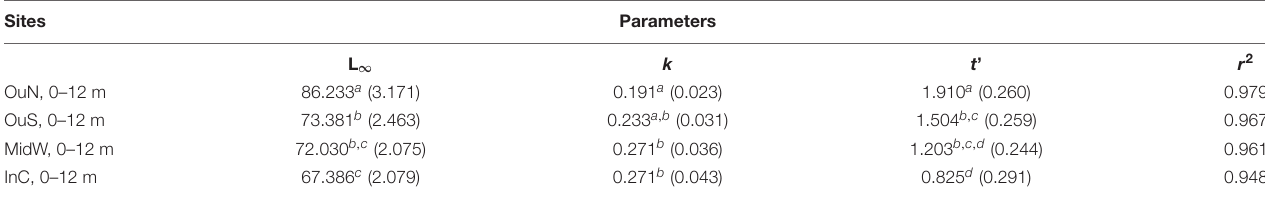
TABLE 4 | Estimated parameters and coefficients of the growth curves for cultivated mussels according to Gompertz model [L t = L ∞ e( − e ( − k ( time − t (cid:48) )) ] for the four cultivation sites under study, March 2015 to July